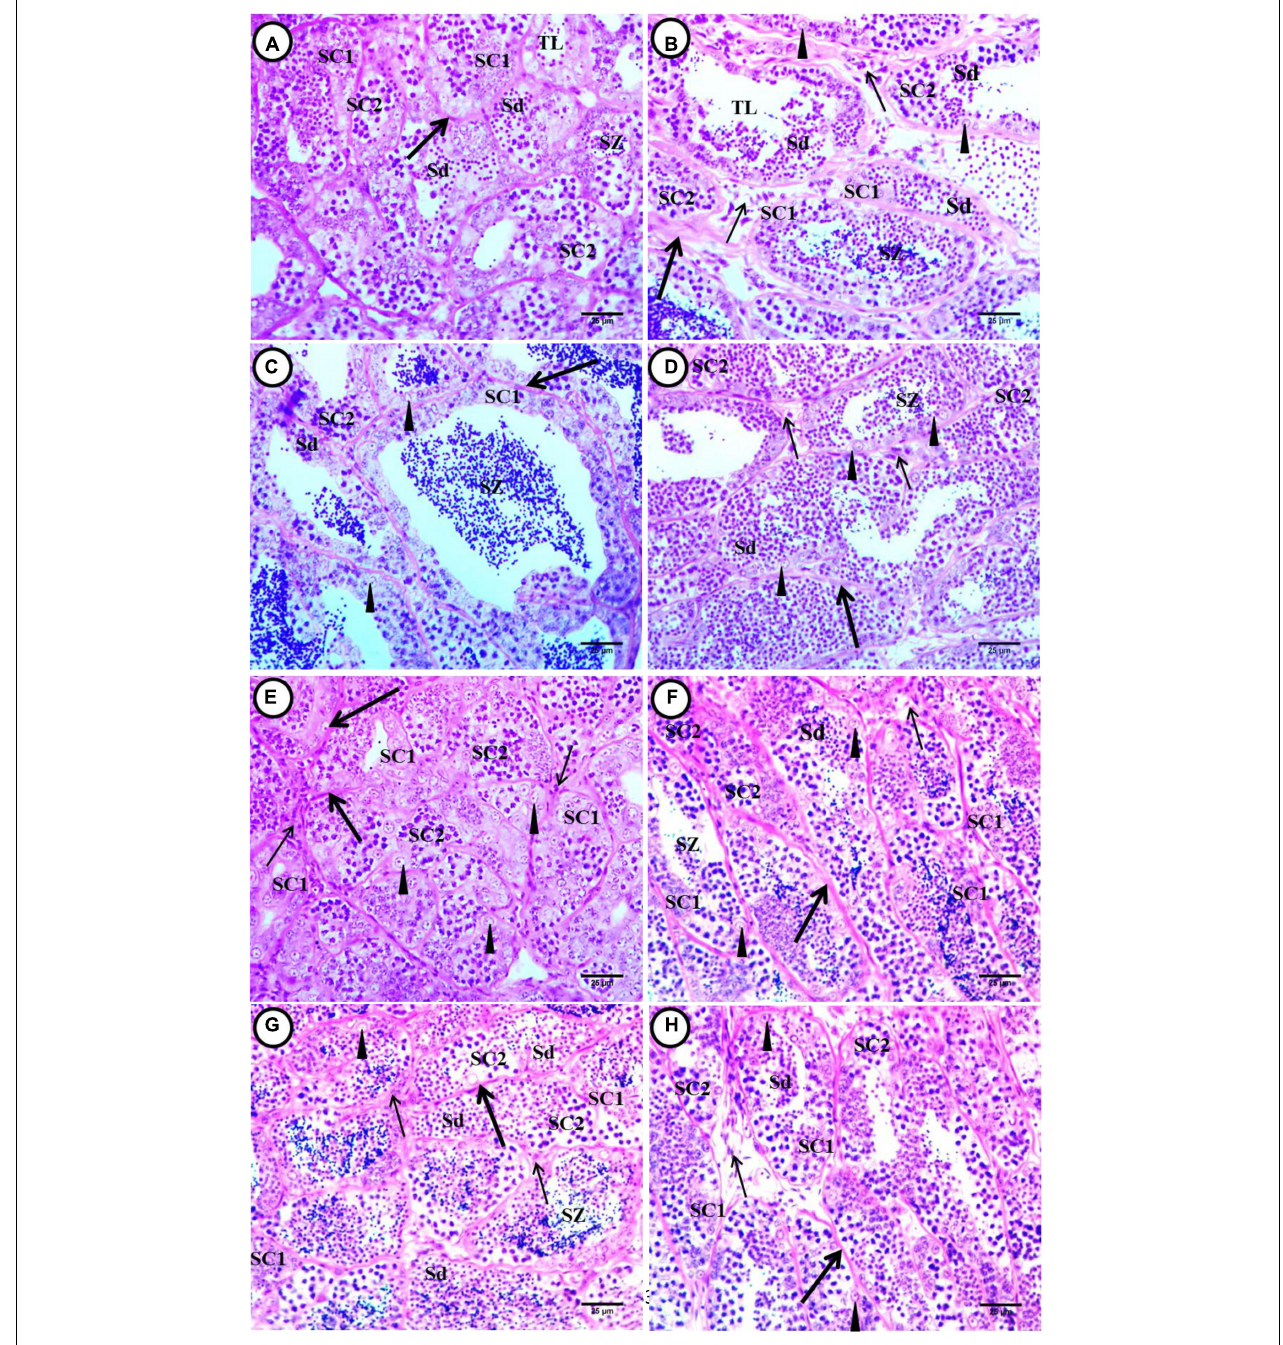
FIGURE 2 | Transverse sections of juvenile African catfish ( C. gariepinus) testes. (A) Control fish after exposure to 4-NP, (B) fish exposed to 0.1 mg/L 4-NP, (C) fish exposed to 0.2 mg/L 4-NP, (D) fish exposed to 0.3 mg/L 4-NP, (E) control fish after recovery period, (F) fish exposed to 0.1 mg/L 4-NP dose after the recovery period, (G) fish exposed to 0.2 mg/L 4-NP dose after the recovery period, and (H) fish exposed to 0.3 mg/L 4-NP dose after the recovery period. Seminiferous tubule contained primary spermatocytes (SC1), secondary spermatocytes (SC2), spermatids (Sd), spermatozoa (SZ), Sertoli cells (arrowhead), lumen tubule (TL), intertubular connective tissue (thick arrow), and interstitial Leydig cells (thin arrow). (H&E × 400).